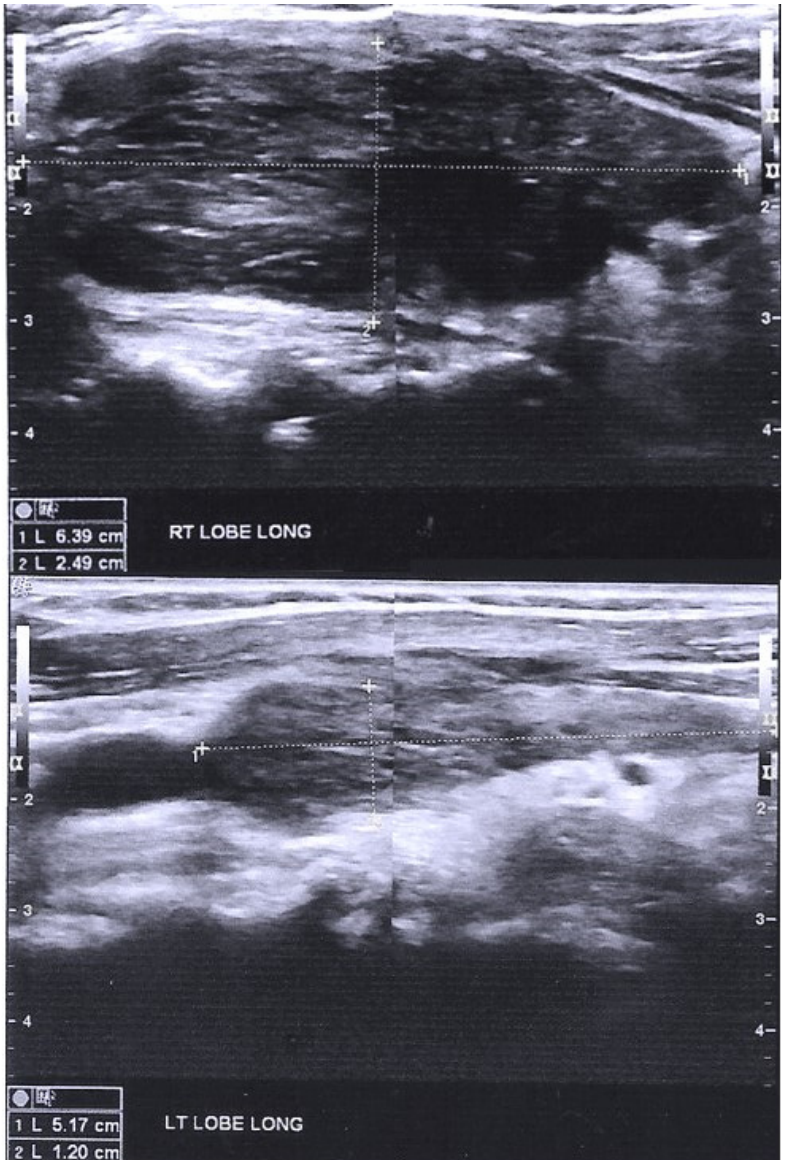
Figure 2. Thyroid sonography of case 2 patient. Thyroid gland is depicted enlarged (Right Lobe 6.39 × 2.49 cm, Left Lobe 5.17 × 1.20 cm) and hypoechoic, with echogenic fibrous septations. Dotted line depicts measurements of thyroid lobes.